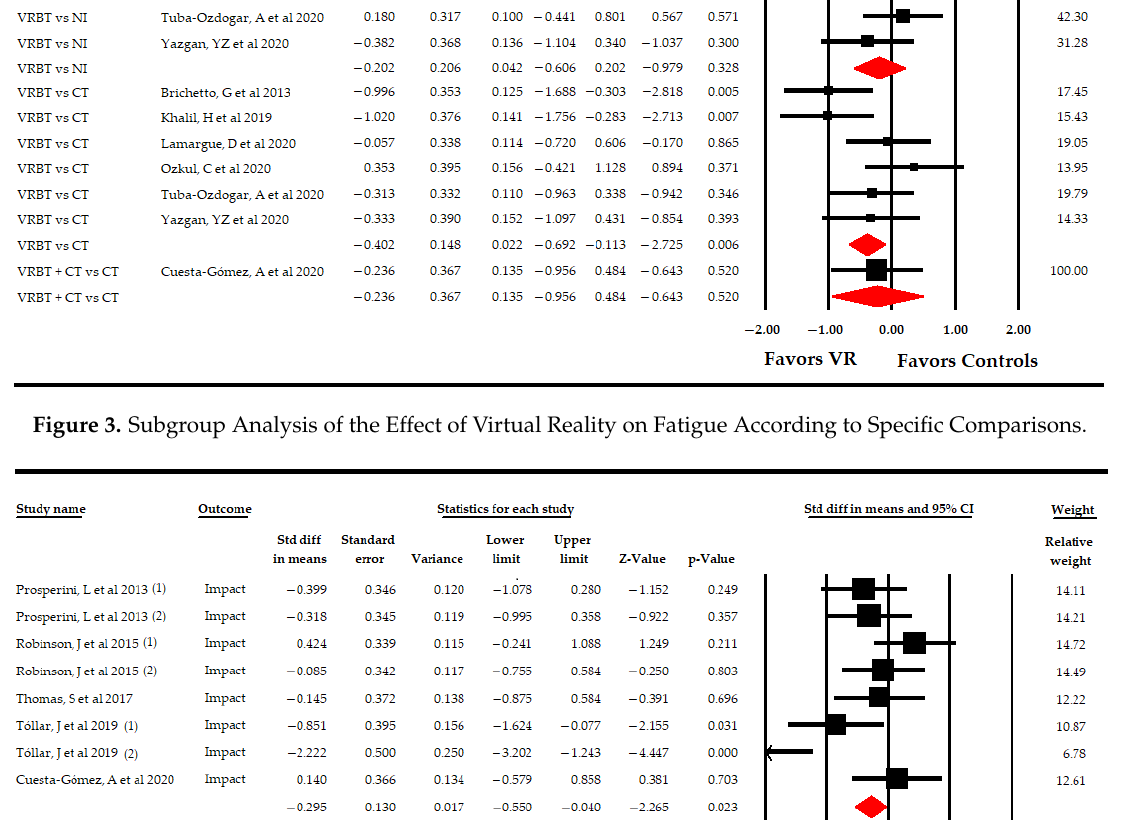
The following specific comparison subgroups were identified: VR vs. NI, VR vs.